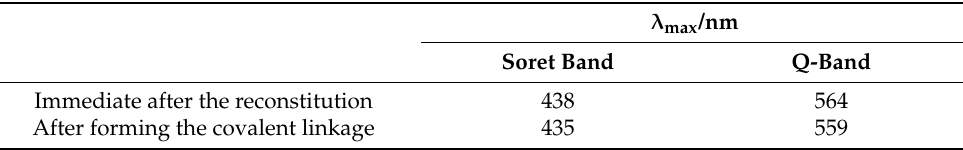
Figure 6. The UV-Vis spectral change of C14A reconstituted with Mn-PPIX (Mn- rC 552 ) in reduced form. The UV-Vis spectrum immediately after the reconstitution (solid line) shows a spontaneous blue shift (dotted line) in the presence of light. An identical shift was observed after the reaction with an organic radical generator. Table 2. Absorption maxima of Mn(II)-C14A recorded immediately after the reconstitution and after the covalent linkage